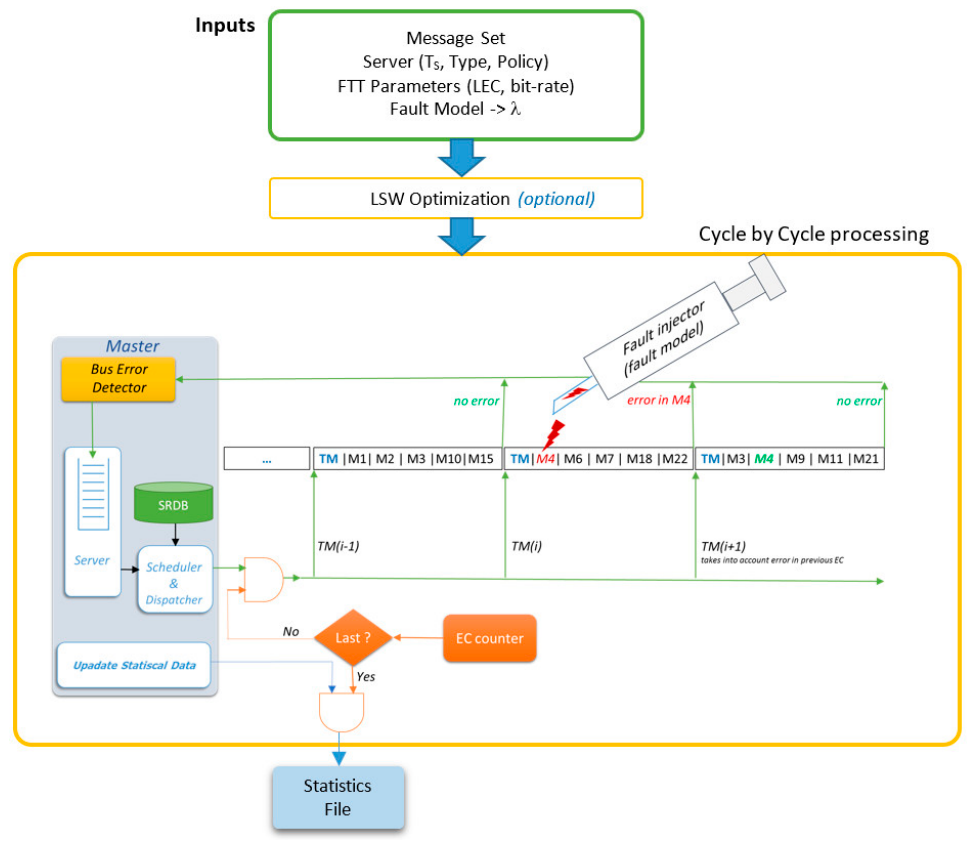
Figure 10 . FTT-CAN simulator architecture. Figure 10. FTT-CAN simulator Table 4 . Comparing analytical WCRT with that observed in simulation for the Updated_SAE message set with LSW = 55.1% of LEC, considering an Aggressive environment.